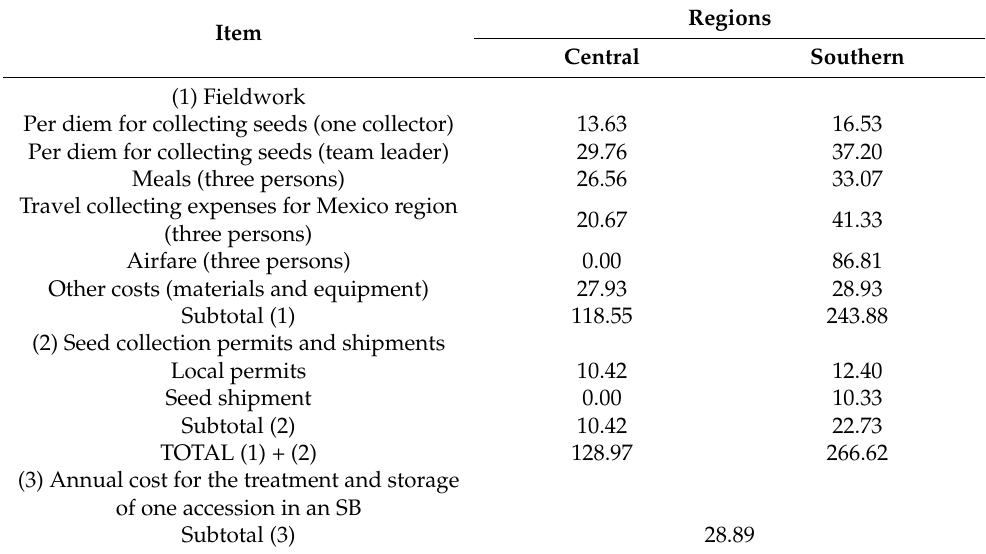
Table 2. Collection costs per accession in different regions of Mexico.